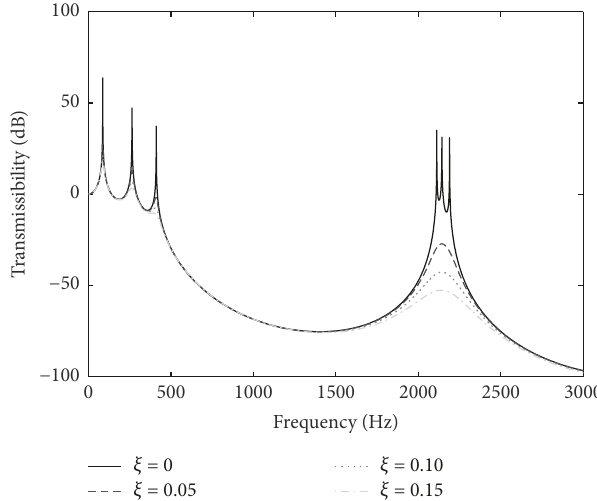
Figure 2: Curves of influence of damping on the vibration transmis-